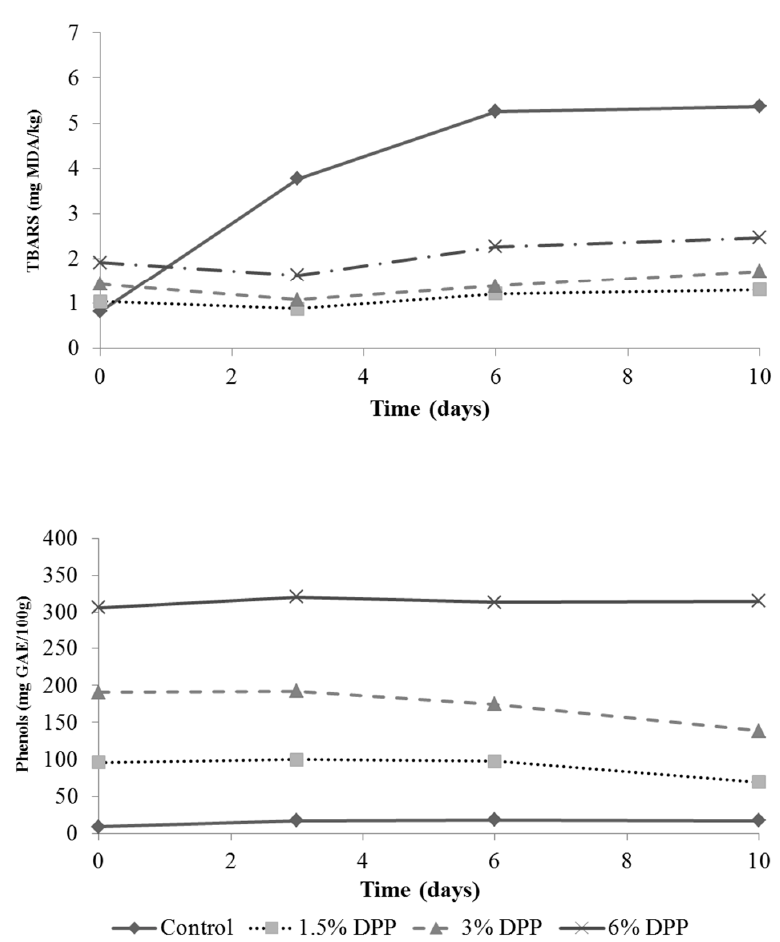
Figure 1. Evolution of the lipid oxidation (TBARS) and total phenolic content of uncooked burgers with date pit powder (DPP) during refrigerated storage. GAE: Gallic acid equivalents; TBARS: Thiobarbituric-acid-reactive substances; MDA: Malonaldehyde.